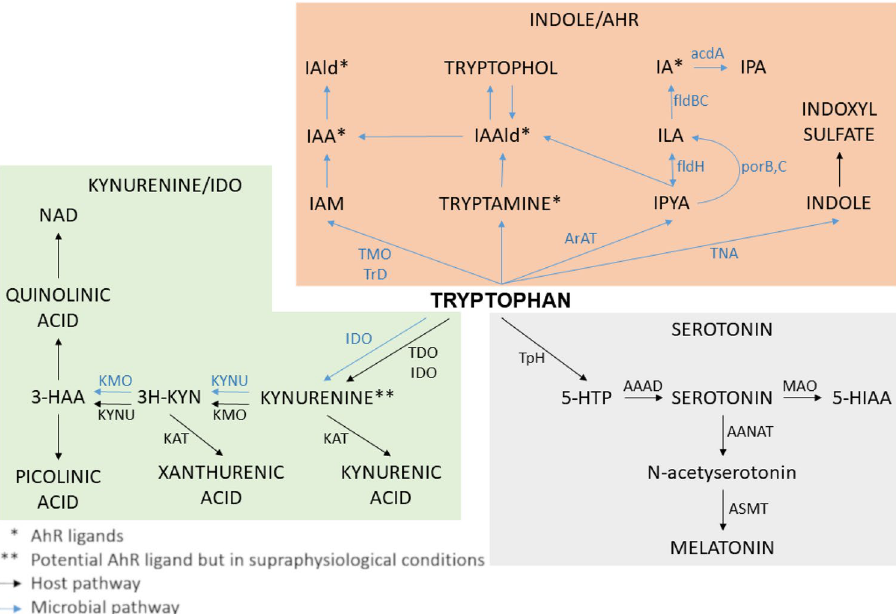
Figure 1. Tryptophan human gut bacterial co-metabolism leading to production of indoles including IPA, IAA, ILA and IS. 3-HAA 3-hydroxyanthranilic acid, 3H-KYN 3-Hyroxykynurenine, 5-HTP 5-hydroxytryptophan, AAAD aromatic amino acid decarboxylase, AANAT aralkylamine N-acetyltransferase, acdA acyl-CoA dehydrogenase, AraT aromatic amino acid aminotransferase, ASMT Acetylserotonin O-methyltransferase, fldBC phenyllactate dehydratase, fldH phenyllactate dehydrogenase, IA indole acrylic acid, IAA indole acetic acid, IAAld indole-3-acetaldehyde, IAld indole-3-aldehyde, IAM indole-3-acetamide, IDO indolamine 2,3-dioxygenase, ILA indole-3-lactic acid, IPA indole-3-propionic acid, IPYA indole-3-pyruvate, KAT Kynurenine aminotransferase, KMO kynurenine 3-monooxygenase, KYNU kynureninase, MAO monoamine oxidase, NAD nicotinamide adenine dinucleotide, porB C: pyruvate : ferredoxin oxidoreductase B and C, TDO tryptophan 2,3-dioxygenase, TMO tryptophan 2-monooxygenase, TNA tryptophanase, TpH tryptophan hydroxylase, TrD tryptophan